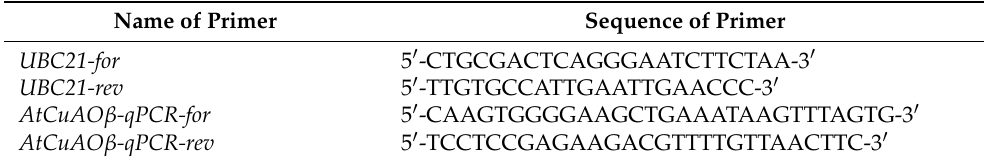
Table 2. Primers used for RT-qPCR analysis on whole Arabidopsis seedlings after MeJA treatments. Name of